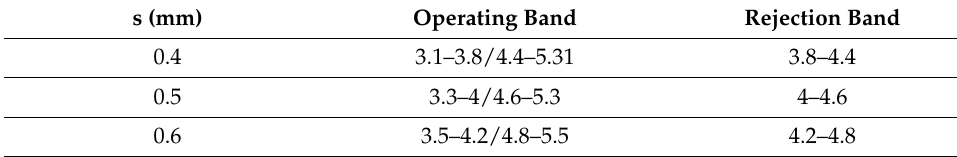
Table 2. Operating frequency and notch bands for different values of s